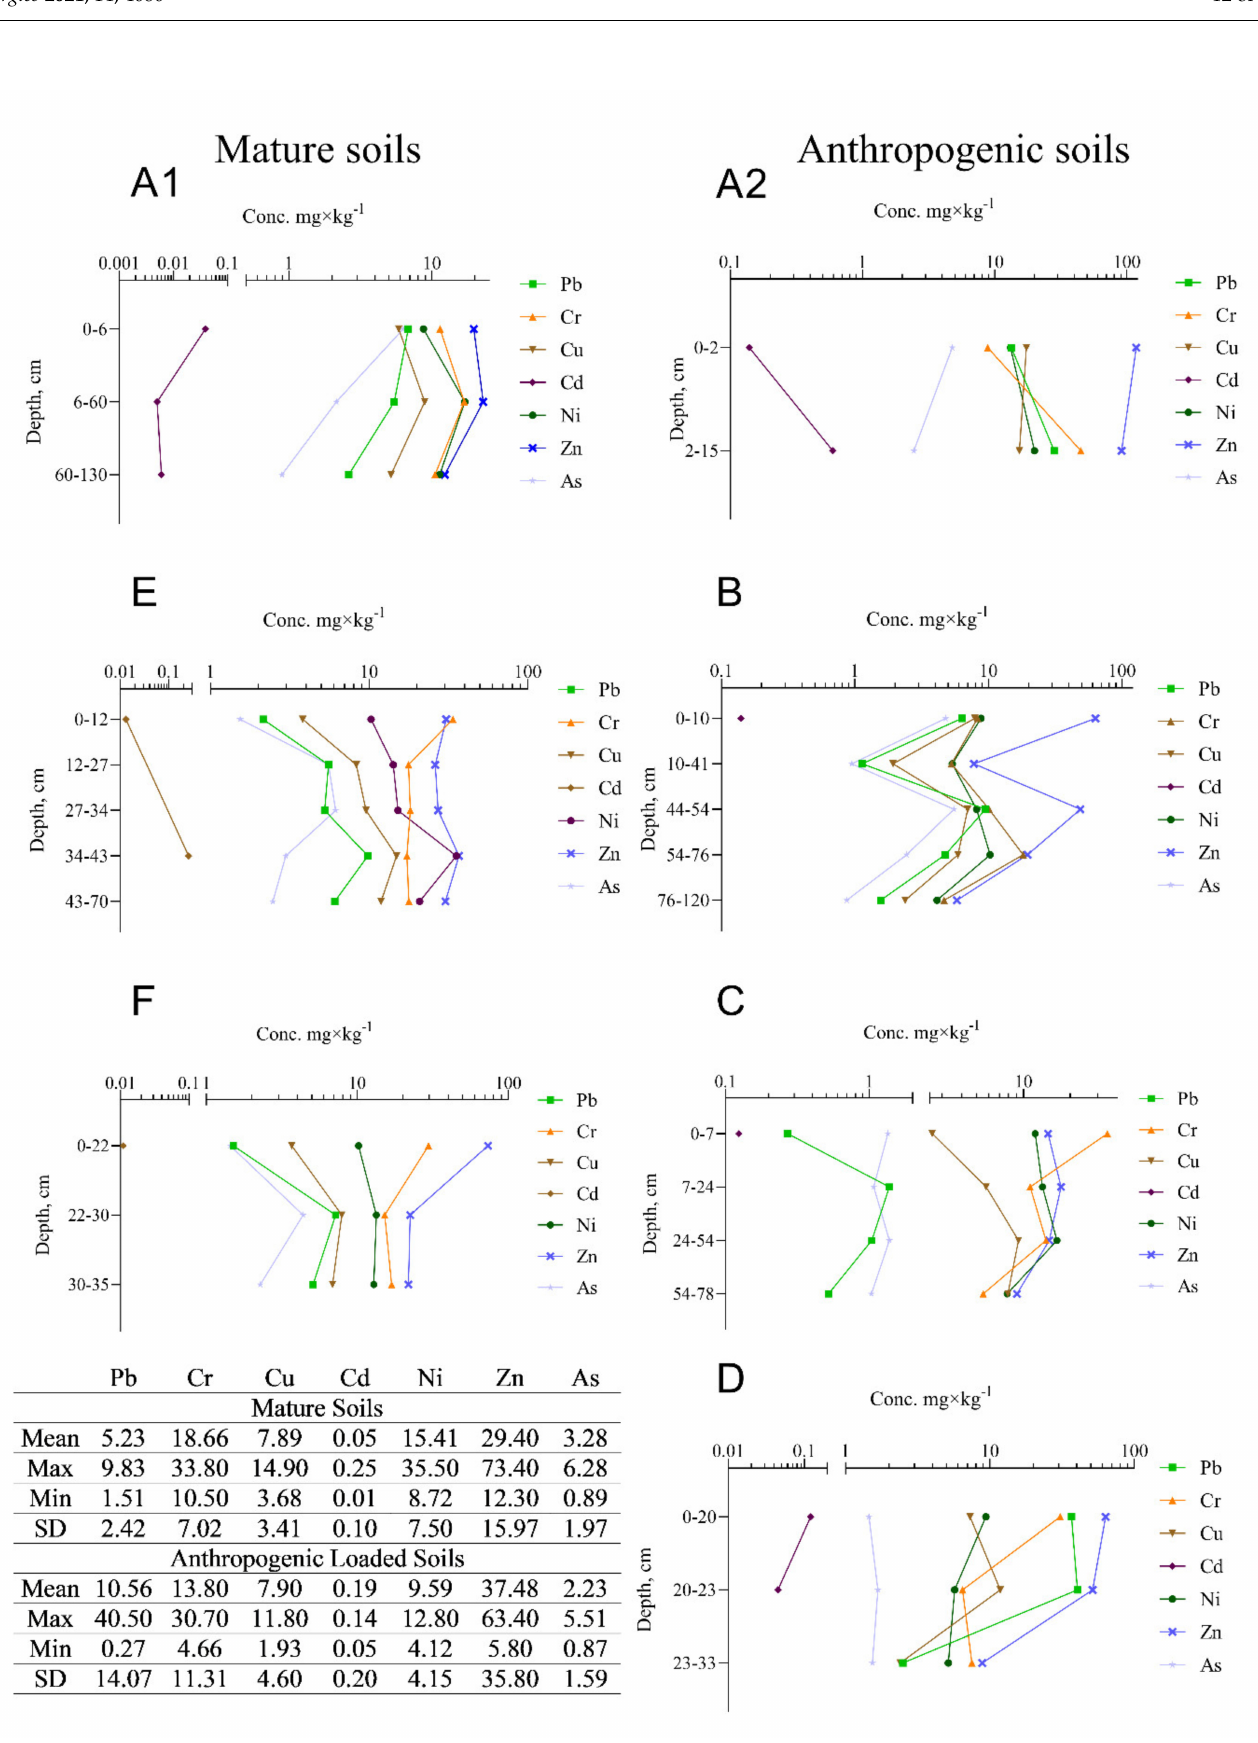
Figure 4. Distribution of trace metals in soil profiles and basic statistics: ( A1 , E , F )—mature soils; ( A2 , B , C , D )—anthropogenic loaded